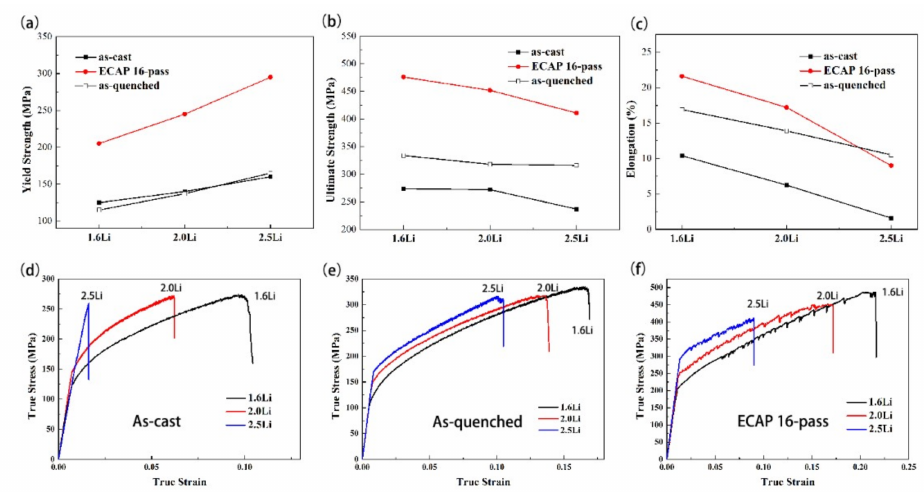
Figure 8. Mechanical properties of Al-5.5Mg-xLi-0.1Zr alloys: Comparison of ( a ) yield strength (YS), ( b ) ultimate strength (UTS) and ( c ) elongation (EL) of the studied alloys under di ff erent states; Stress-strain curves of the studied alloys under di ff erent states involving ( d ) as-cast, ( e ) as-quenched and ( f ) ECAP for 16